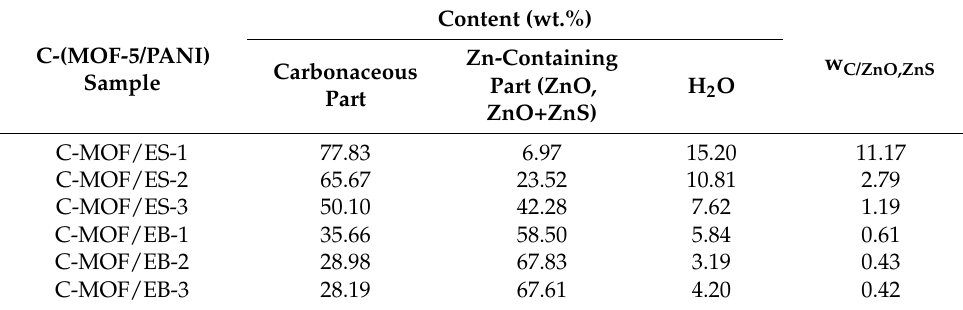
Table 3. The content of the carbonaceous part, Zn-containing part (ZnO, ZnO+ZnS) part, and H 2 O, as well as the mass ratio of the carbonaceous part and Zn-containing part, (w C/ZnO,ZnS ), in C-(MOF-5/PANI) composites, determined by